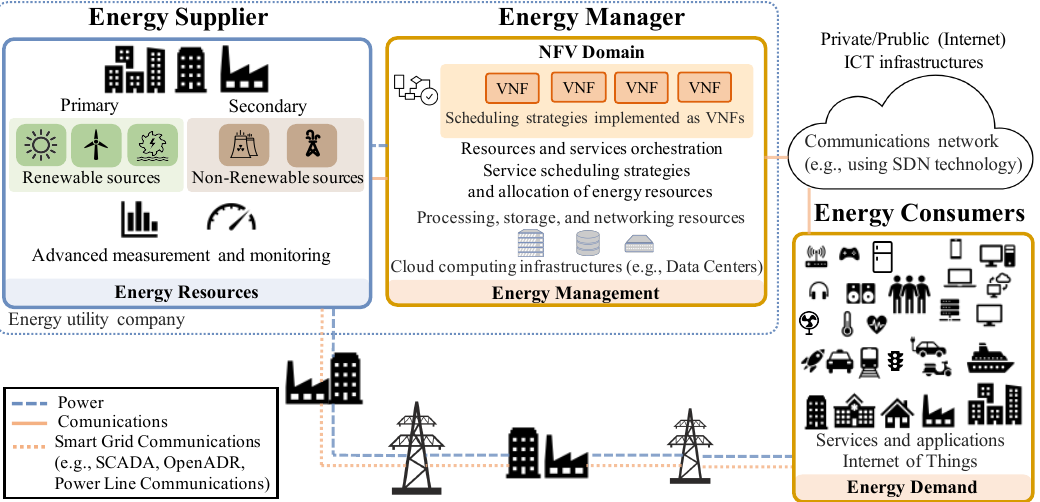
Overview of an Network Functions Virtualization (NFV)-enabled adaptive energy management